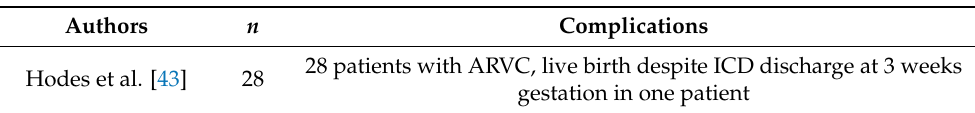
Table 3. Subgroup analysis of the ICD population in a study investigating the maternal and fetal outcome of pregnant women with an underlying ARVC.